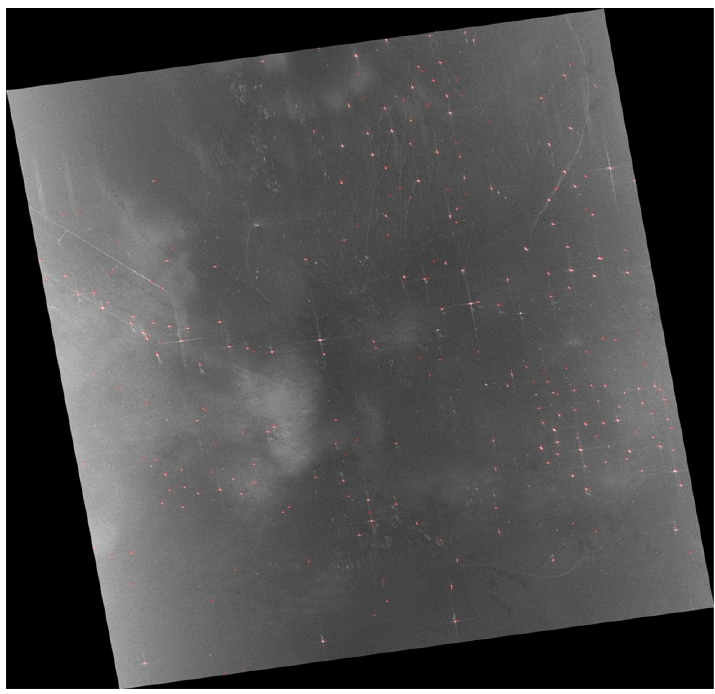
Figure 9. The experimental robustness of the RetinaNet for ship detection in the ( a ) Ocean and ( b ) Harbor: The red rectangles, green ellipses, and magenta ellipses indicate the detected ships, false alarms, and the missing ships by the model.